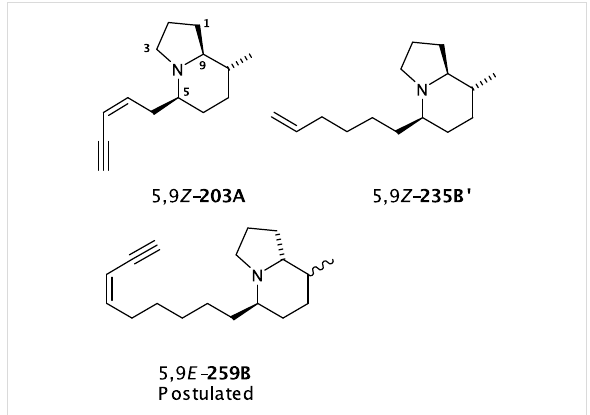
Figure 1: Subclasses of diastereoisomeric 5,8-disubstituted alkaloids. The absolute stereochemistry of 5,9 Z - 203A and 5,9 Z - 235B' are